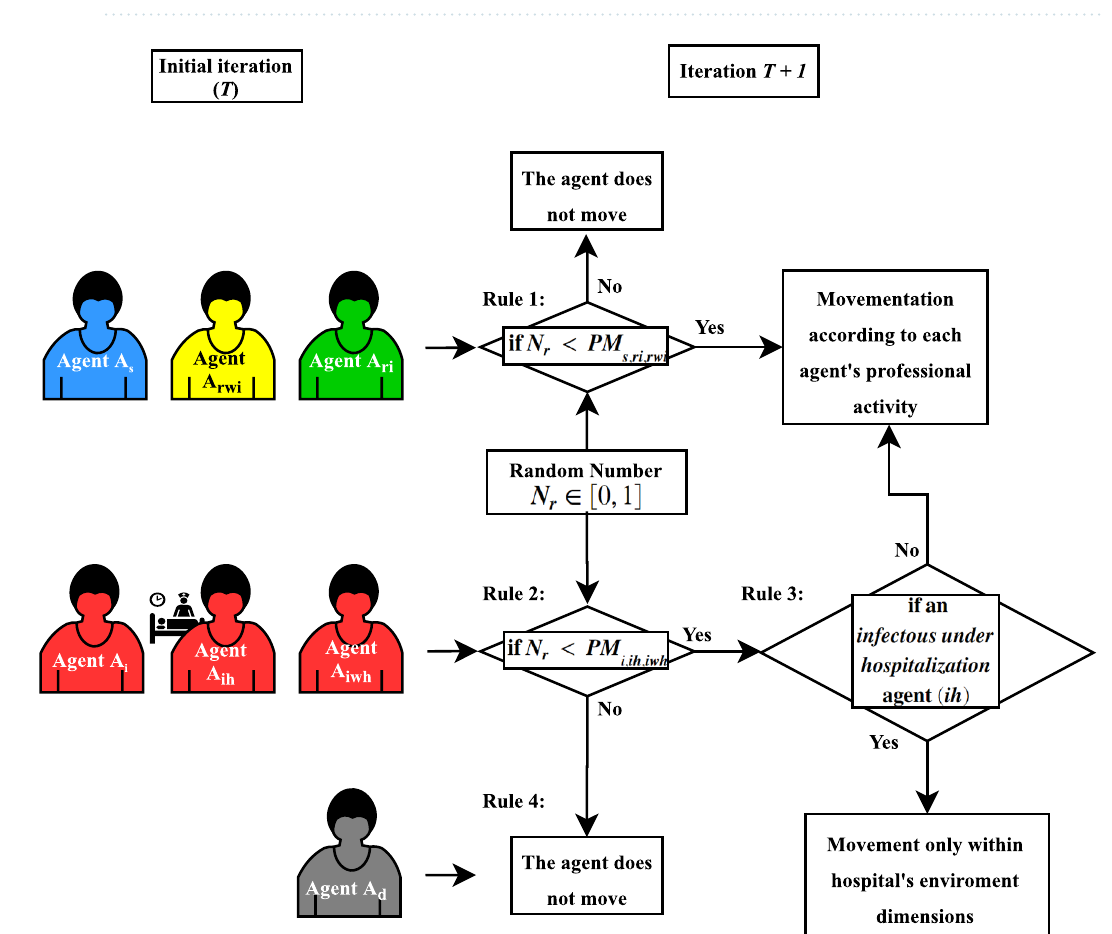
Figure 5. Roadmap of the Movement’s